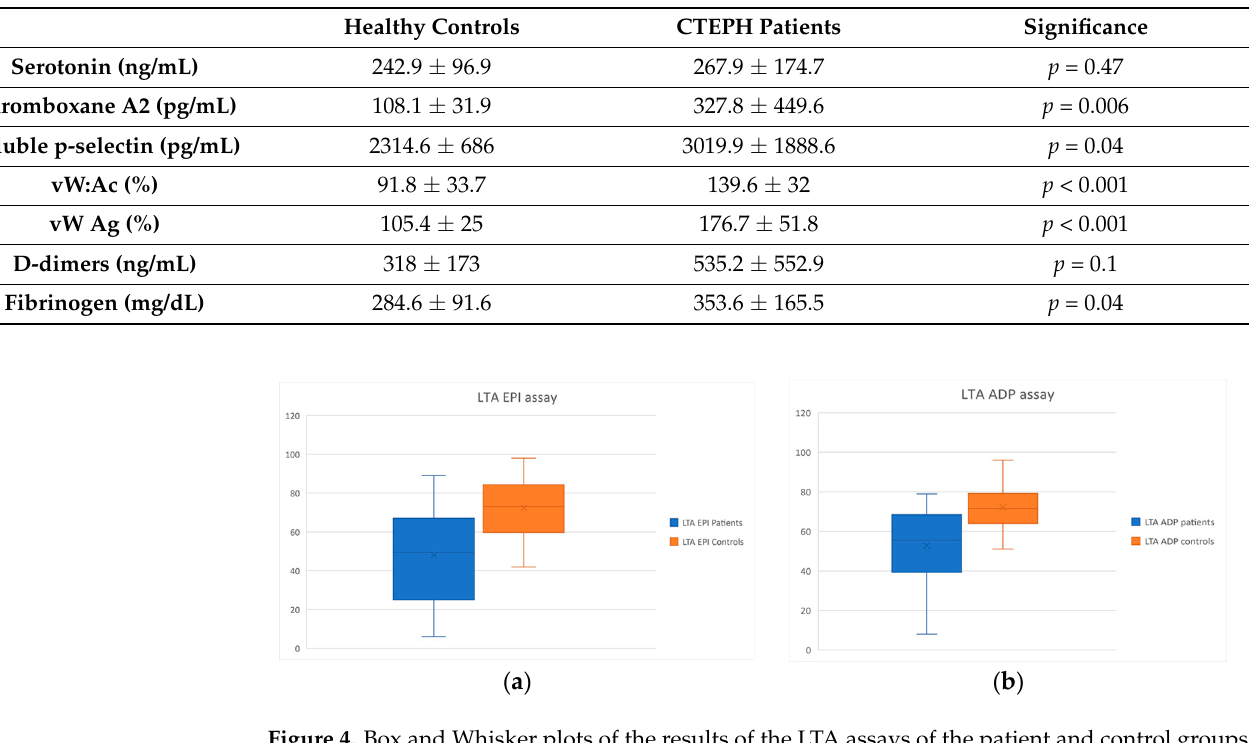
Table 4. Endothelial and coagulation variables in CTEPH patients and healthy controls.